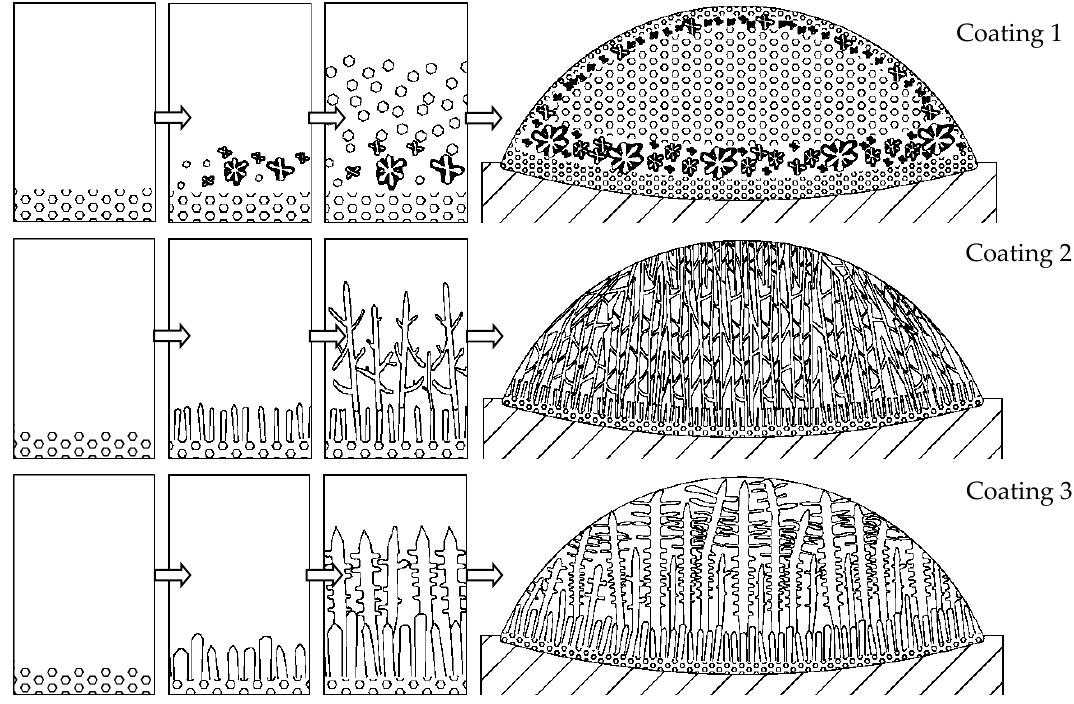
Figure 11. Schematic illustration of microstructures evolution in solidification process of three coatings.